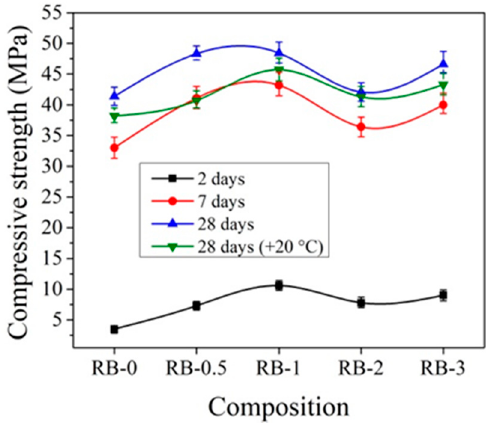
Figure 13. Compressive strength of concrete with CEM IIR samples at 0 °C initial curing (28 days (+20 °C)—reference samples prepared and cured at +20 °C).